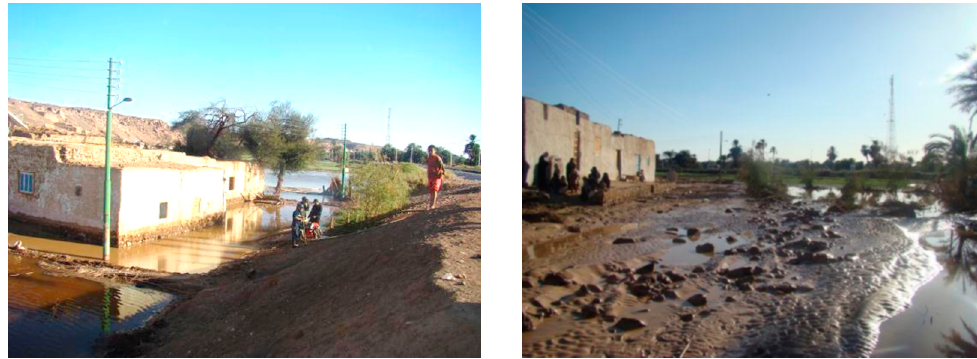
Figure 2. Roads and buildings affected by floodwater torrents in Egypt.